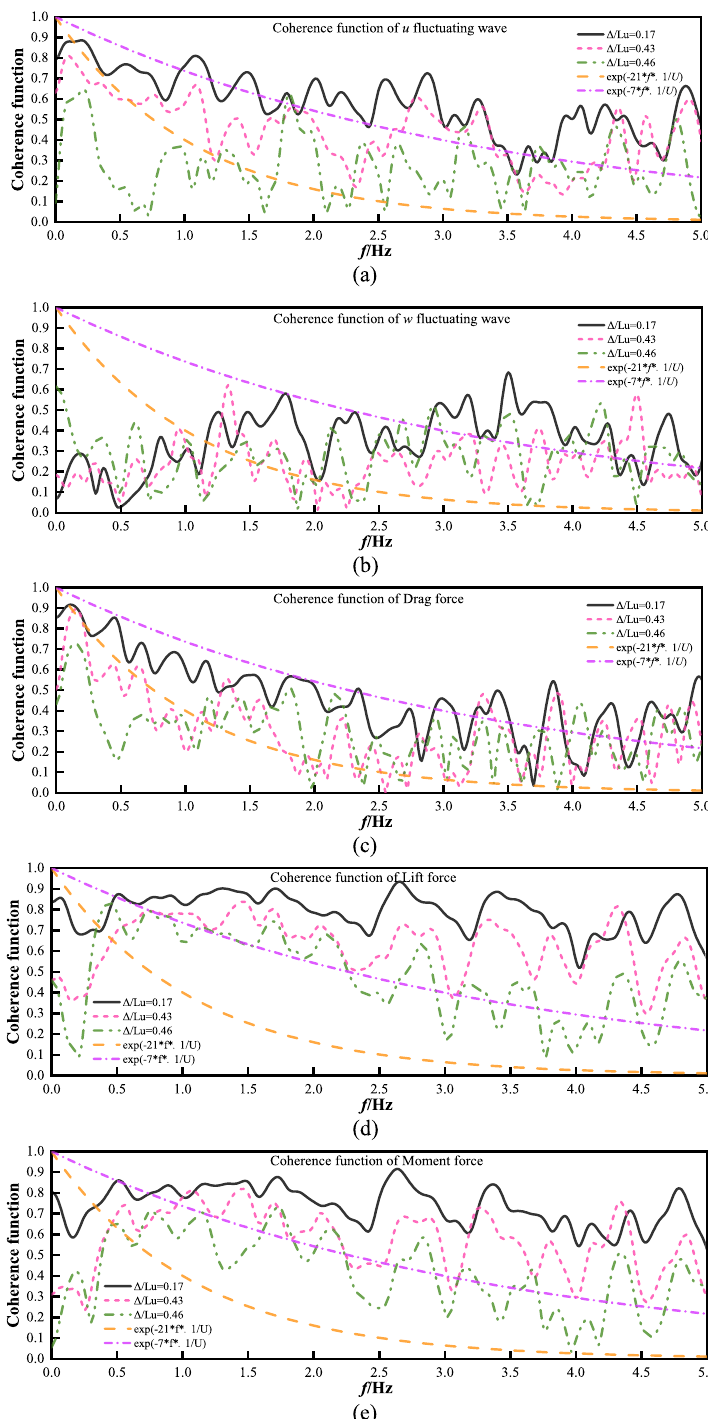
Fig. 14 Comparison between the aerodynamic force coherence and the incoming turbulence spatial coherence. a Curve of the along-wind velocity spatial related functions. b Curve of the vertical-wind velocity spatial related functions. c Curve of the Drag-force spatial related functions. d Curve of the Lifting-force spatial related functions. e Curve of the Moment-force spatial related